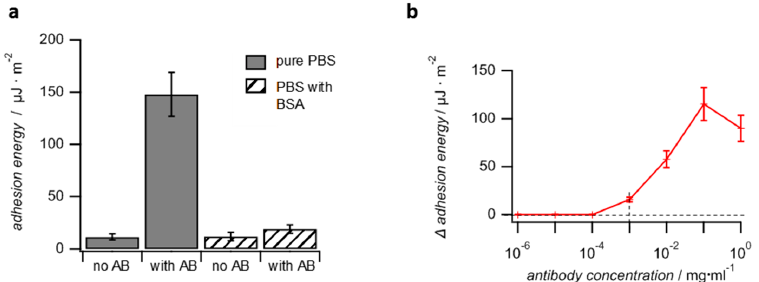
Figure 6. Results for SCPs adhesion assays for antibody detection. ( a ) Adhesion energies of BSA-FITC SCPs after incubation with antibodies (AB) on protein A slides. Measurements without